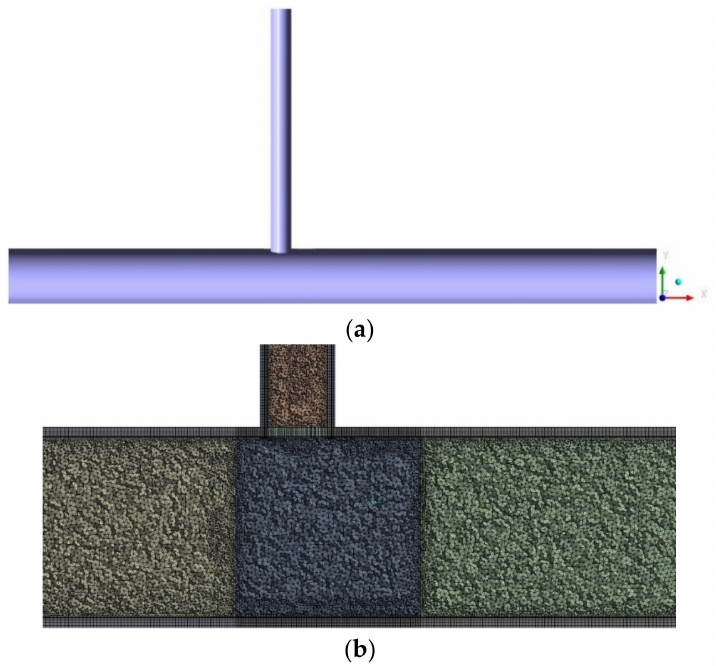
Figure 2. CAD model cross section ( a ) and computational mesh fragment in the mixing zone of the T-junction ( b